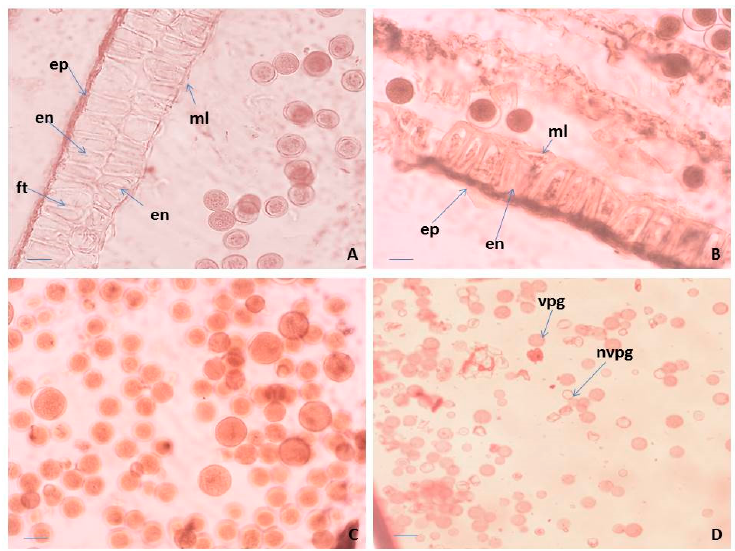
Figure 2. Anther and male gametophyte development. ( A ) Anther wall and mature pollen in an anther locule of “pin” floral morph, ( B ) anther wall and mature pollen, ( C ) mature pollen in an anther locule of “thrum” floral morph, and ( D ) viable and unviable pollen after acetocarmine testing. ep—epidermis; en—endothecium; ft—fibrous thickenings of the endothecium cells; ml—middle layer; vpg—viable mature pollen; nvpg—unviable mature pollen. Scale bar = 20 μ m ( A , B ); 50 μ m ( C ); 100 μ m ( D ).